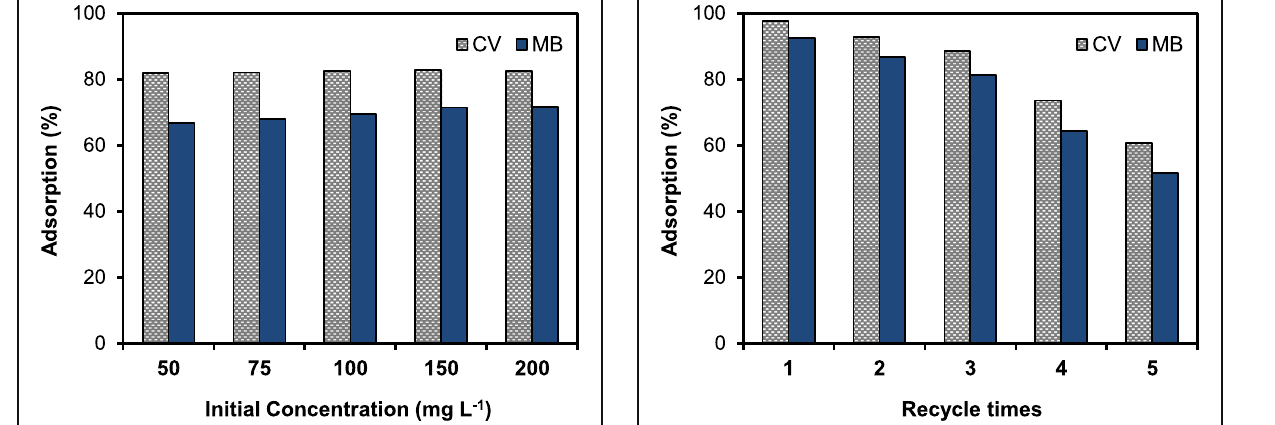
Fig. 9 Reuse the ASS adsorbent on the adsorption of CV and MB dyes (adsorbent dose of 50 mg, adsorbate concentration of 200 mg L − 1 , volume of adsorbate of 20 mL, contact time of 60 min, pH of 8, and temperature of 27